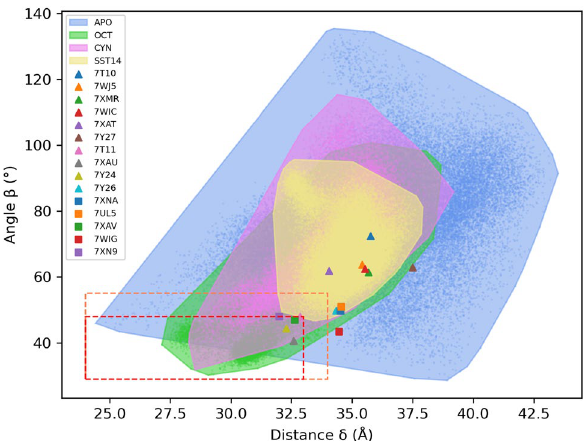
Figure 2. ECL2 opening and closing movements. Each point of the plot refers to a frame of the MD trajectories. The results of SST14, OCT, CYN and apo structures are coloured in yellow, green, magenta and blue, respectively. Threshold values of distance and angle are indicated. The red box includes the frames in which the ECL2 is in the closed conformation, the orange box indicates the border between open and closed conformations. The distance values range from 24 to 44 Å, the angle values from 29 all the frames (dots) corresponding to the four systems. The triangles and squares represent the experimental structures of SSTR2 (list of all experimental structures in Table